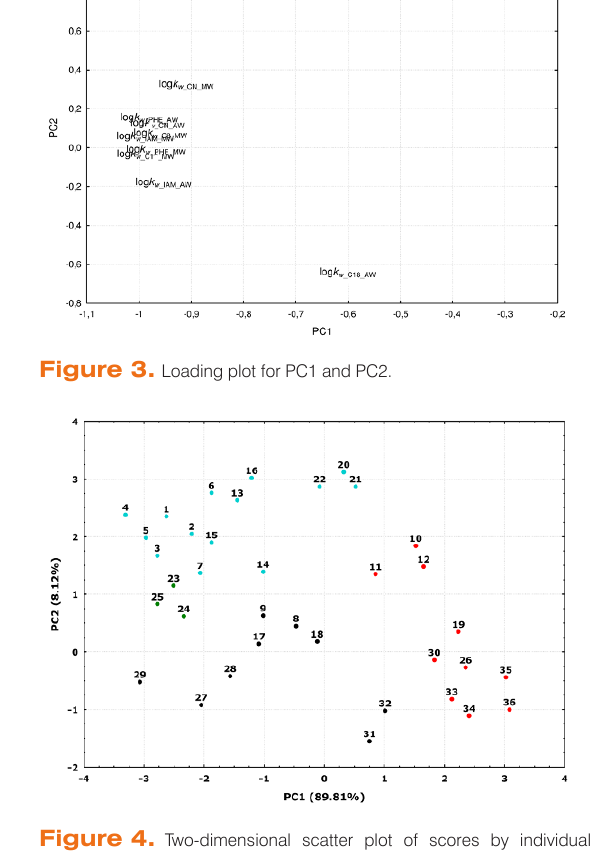
Figure 4. Two-dimensional scatter plot of scores by individual compounds in two first principal components: PC1 and PC2 (blue – strong deterrents of Leptinotarsa decemlineata Say larvae and beetles; red – strong deterrents of larvae; green – strong deterrents of beetles; black – weak